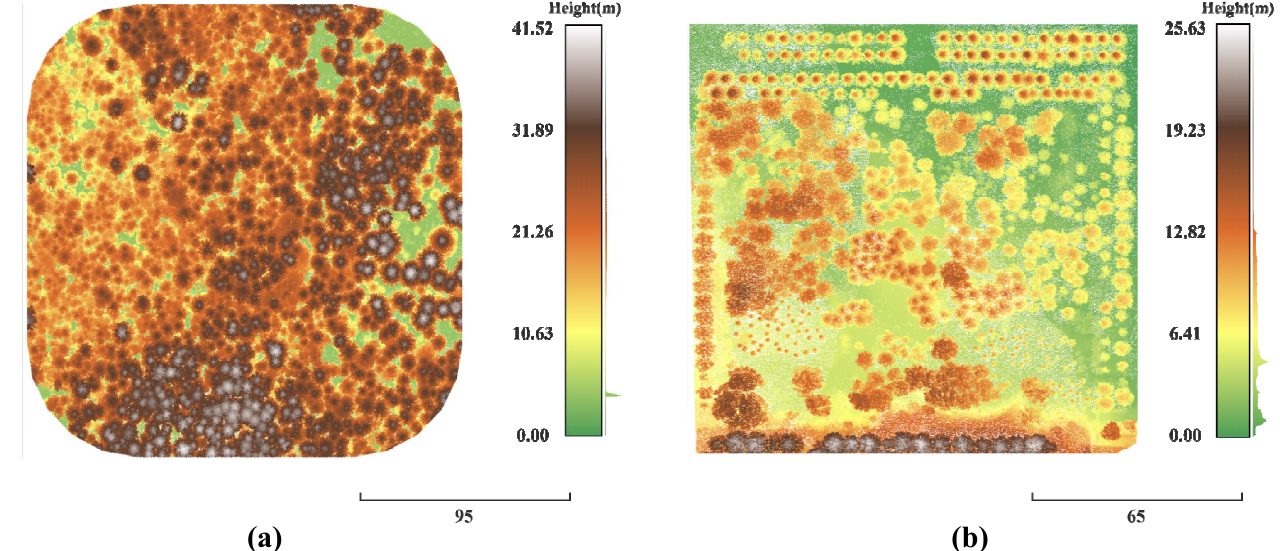
Figure 1. Schematic diagram of the point cloud data of the experimental area. ( a ) Trento; ( b ) Qing-